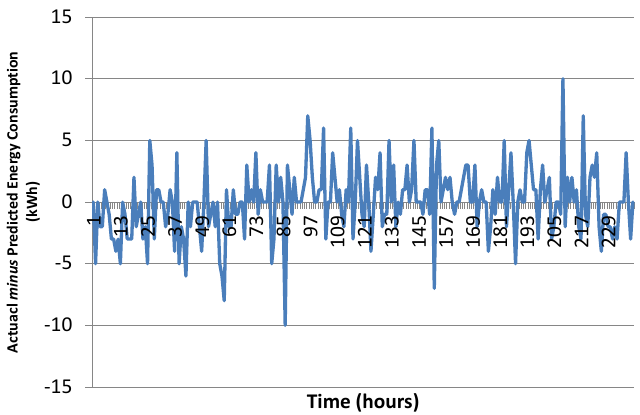
Figure 11. Error in prediction results of the proposed model for 10 days hourly data (RMSE =